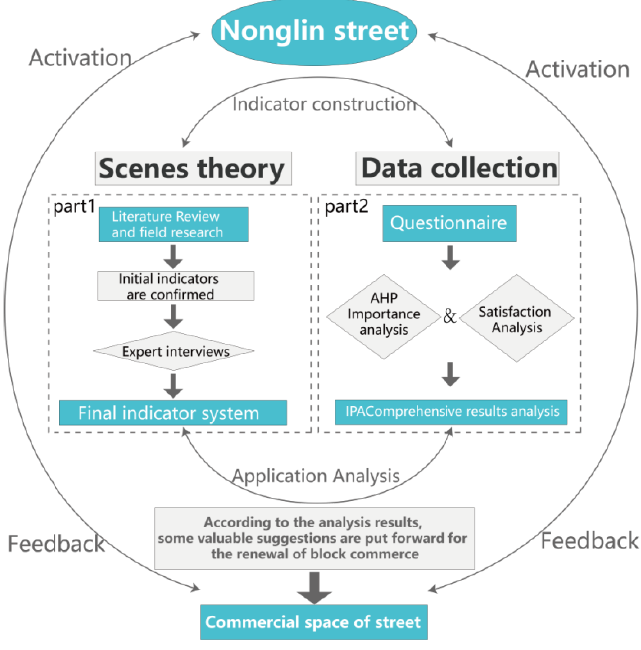
Figure 2. Methodology and application step diagram.